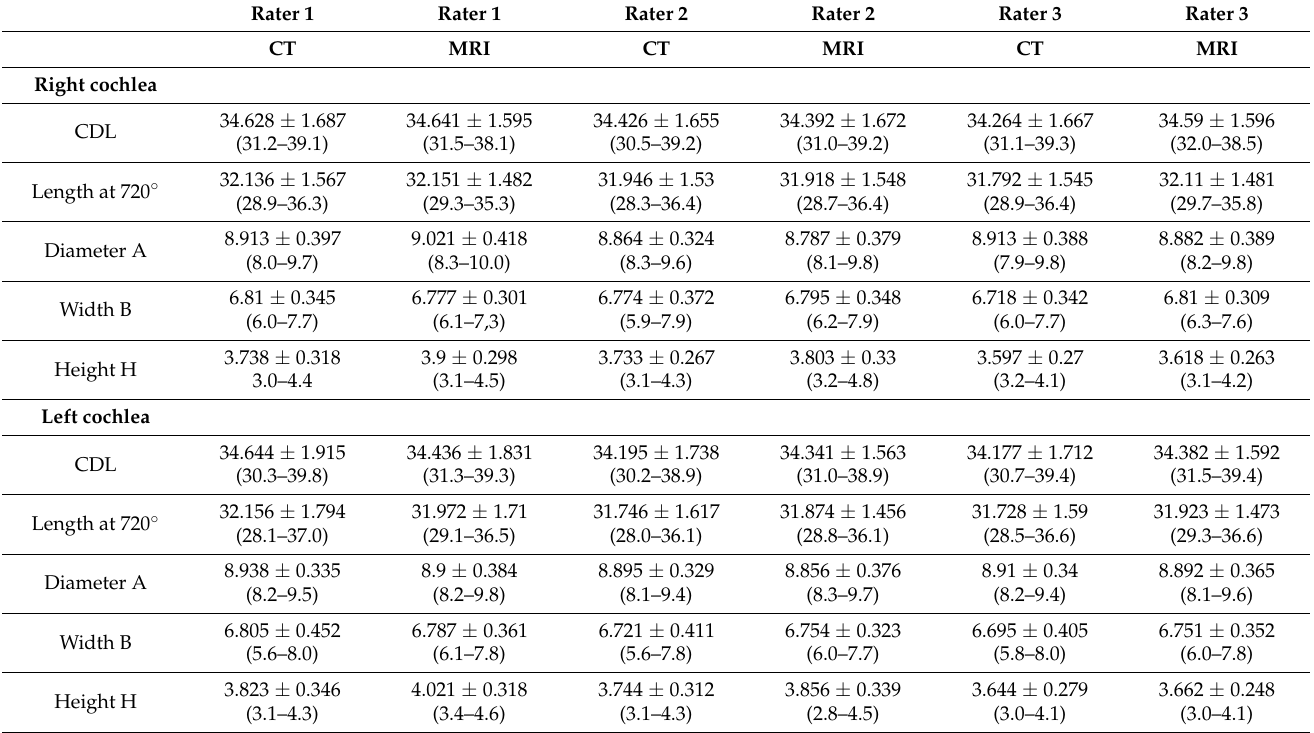
Table 1. Length of the cochlea (CDL = cochlear duct length, length at 720 ◦ = cochlear length measured at 720 ◦ (2 turns), Diameter A = transverse diameter A of the basal turn of the cochlea, Width B = transverse width B of the basal turn of the cochlea, Height H = height of the cochlea), mean ± standard deviation and (range) of absolute lengths